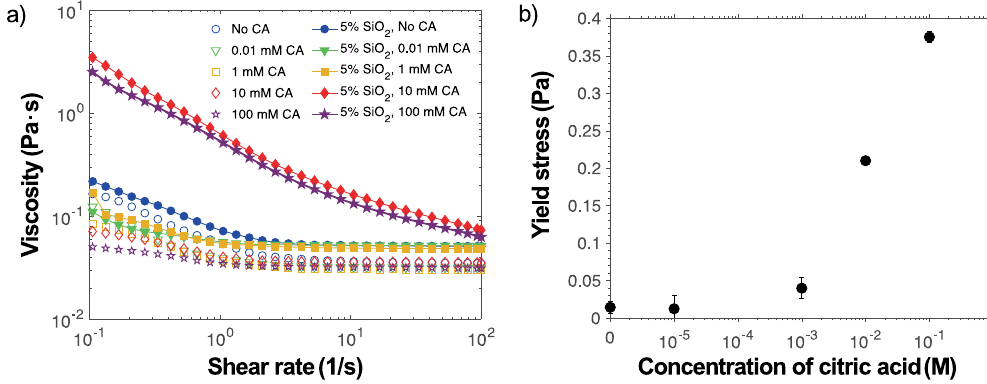
Figure 2. Rheology of the solutions including ( a ) viscosity as a function of shear rate of aqueous PEO (open symbols) and SiO 2 microsphere-PEO solutions (closed symbols) with added citric acid 0 ≤ C ca ≤ 0.1 M. Solutions having no added citric acid have pH of 7.5 and those at C ca = 0.1 M have pH of 2.5. Concentrations in each sample are w PEO = 0.05 and microsphere volume fraction of φ 0 = 0.05. Yield stress of SiO 2 microsphere- PEO solutions ( b ) increases significantly with sufficient added citric